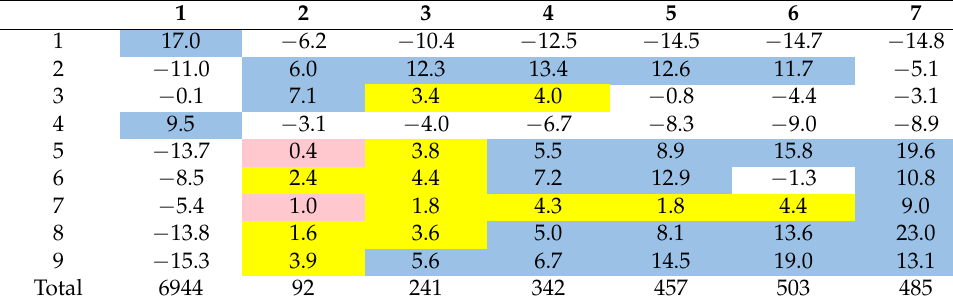
Table A12. Theoretical frequencies DUF 2006